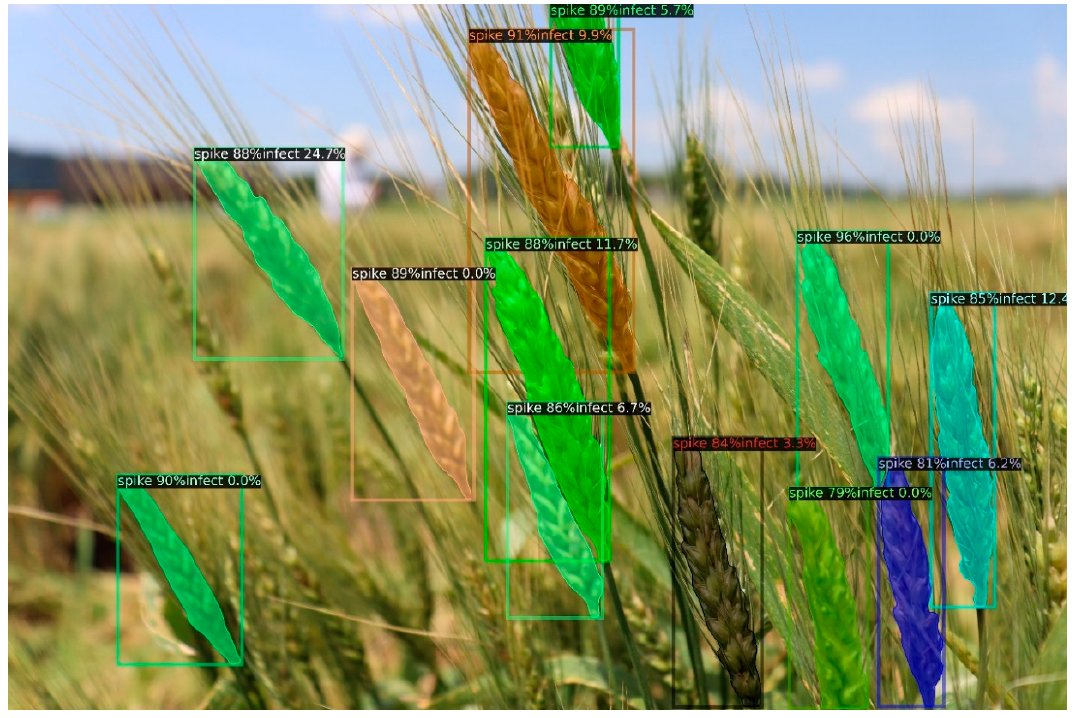
Figure 8. Visualization of the recognition accuracy and disease severity of different wheat spikes from a full-sized image based on automatic tandem dual BlendMask framework.